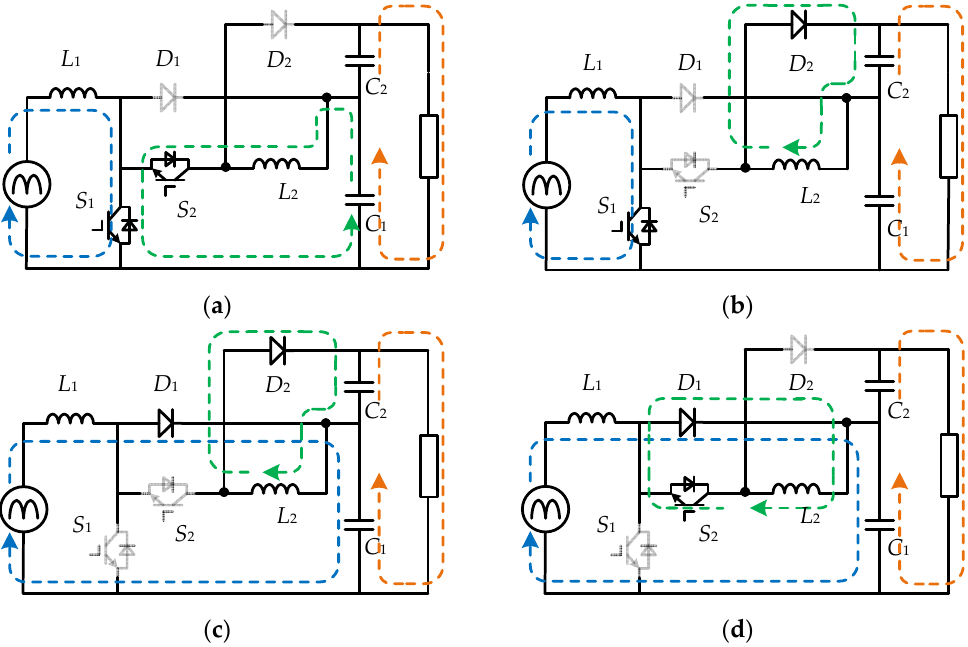
Figure 2. Operation modes of asymmetric split-capacitor APDC. ( a ) Mode 1 (S 1 = ON, S 2 = ON). ( b ) Mode 2 (S 1 = ON, S 2 = OFF). ( c ) Mode 3 (S 1 = OFF, S 2 = OFF). ( d ) Mode 4 (S 1 = OFF, S 2 = ON).